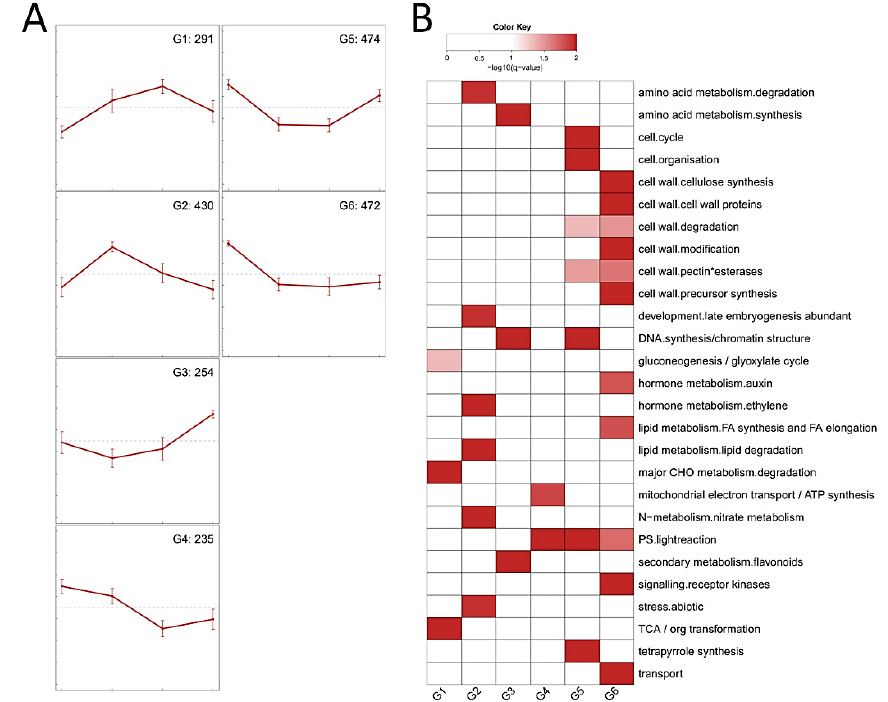
Figure 3. Transcriptional changes of genes involved in salt stress. ( A ) Gene expression patterns of six groups (G1–G6) under salt treatment. The samples (from left to right) are derived from 0, 6, 12, and 24 h after salt treatment, respectively. Error bars represent standard deviation, the numbers of DE genes are indicated in the upper right corner. ( B ) Functional enrichment of genes from each group in ( A ).